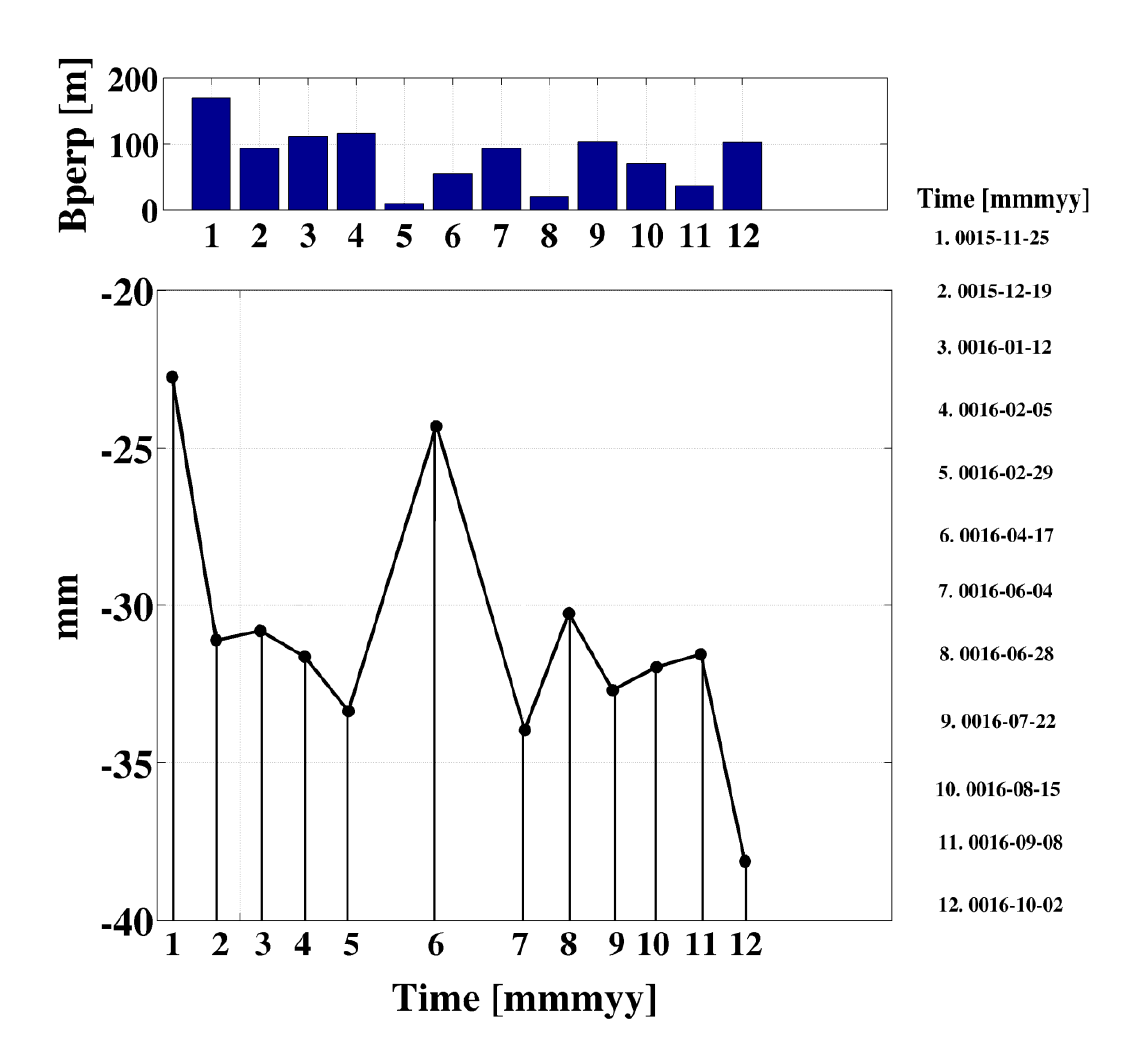
Figure 5. Time series velocity plot for a sample ps